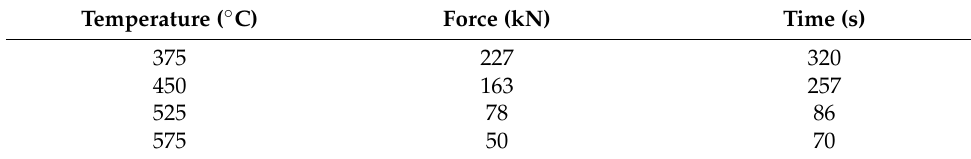
Table 2. Parameters obtained in the extrusion of green compacts.